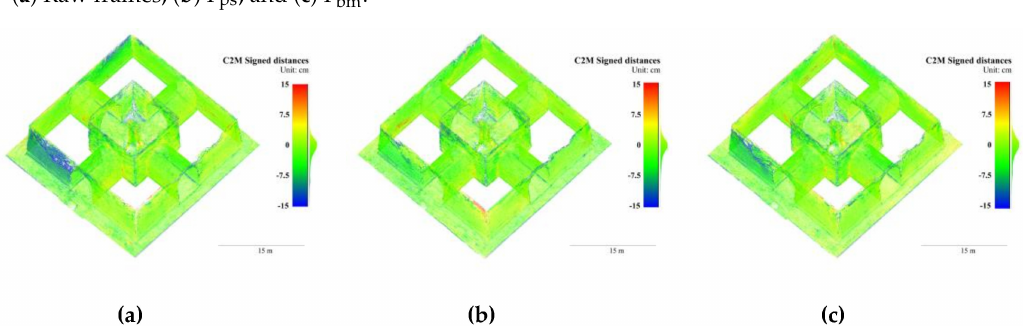
Figure 10. 3D points colored in signed distances to the GTM with variable blur filters of the Pavilion. ( a ) Raw frames; ( b ) F ps ; and ( c ) F bm